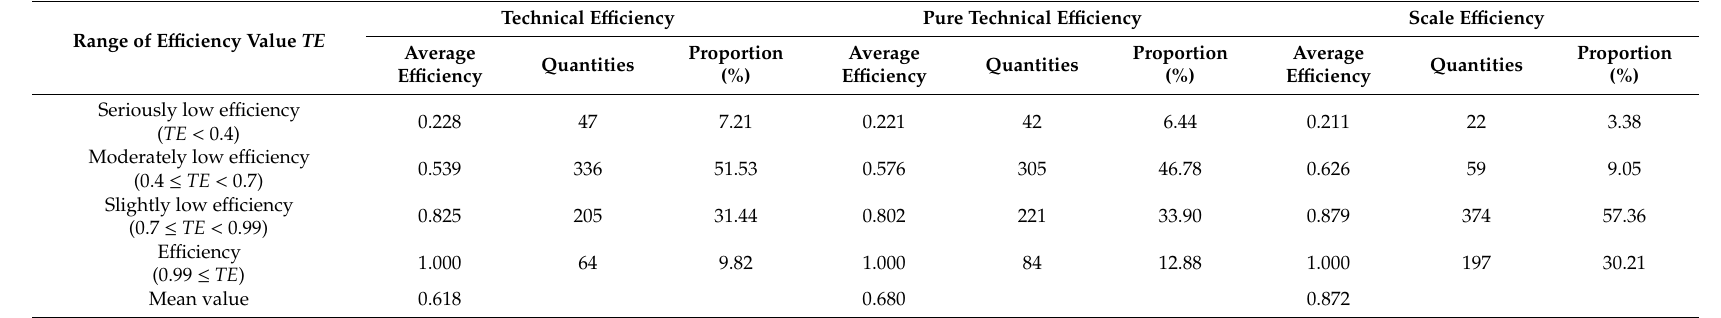
Table 6. DEA Analysis results of new soybean producers’ technical e ffi